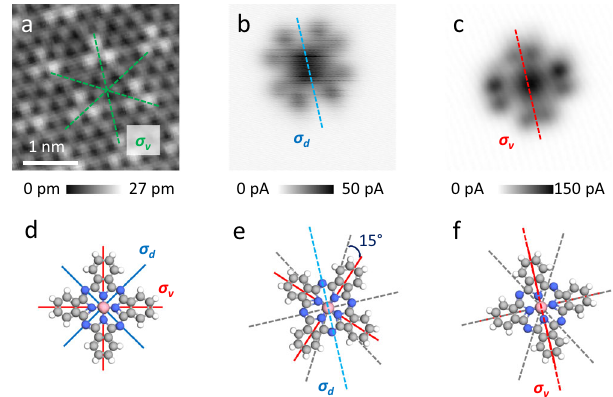
Fig. 1 Absorption symmetry and spectral fi ngerprint of Cobalt phthalocyanine (CoPc) molecules on 2H-NbSe 2 . a Constant current image of the 2H-NbSe 2 surface showing the 3 × 3 charge-density wave superstructure ( V = − 10 mV, I = 1 nA). Here, V is the bias voltage, and I is the tunneling current. b , c Constant-height scanning tunneling microscopy images of two CoPc molecules ( V = 400 mV) adsorbed in different orientations. Colored dashed lines in a – c mark the different mirror planes of the CoPc molecules and the 2H-NbSe 2 surface. d Model of the CoPc molecule with its vertical σ v (red lines) and diagonal σ d (blue lines) mirror plane symmetries. e , f Absorption models of CoPc molecules on 2H-NbSe 2 . While the molecule in e is rotated by 15 ∘ with respect to one of the three principal axes of the substrate (gray dashed lines), the molecule in f is